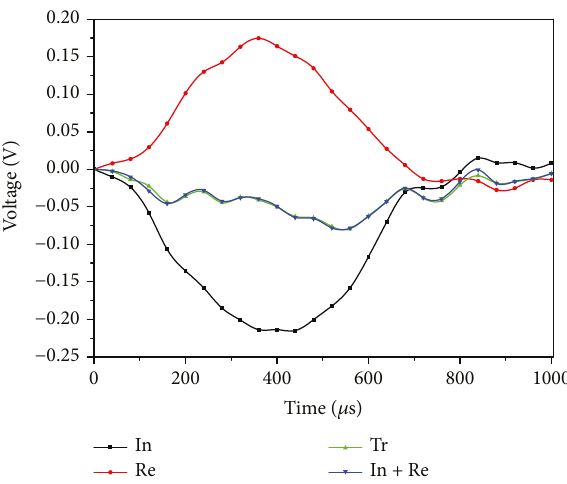
Figure 10: The extracted signals in a typical SHPB test (In, Re, and Tr denote incident, re fl ected, and transmitted wave, respectively).